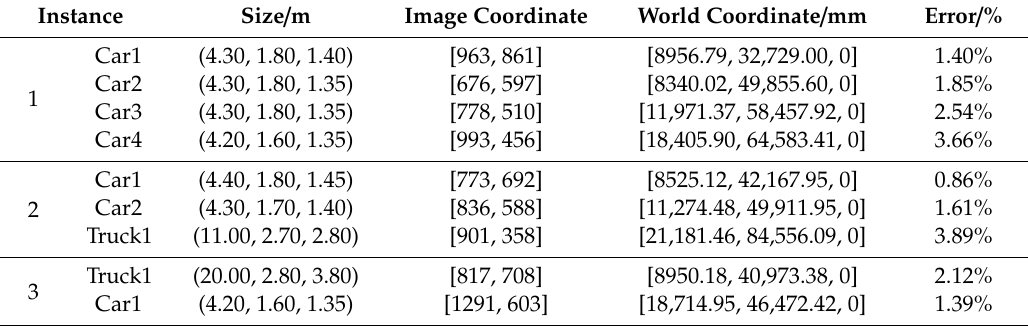
Table 3. Measurement of vehicle spatial distribution errors in dataset scene